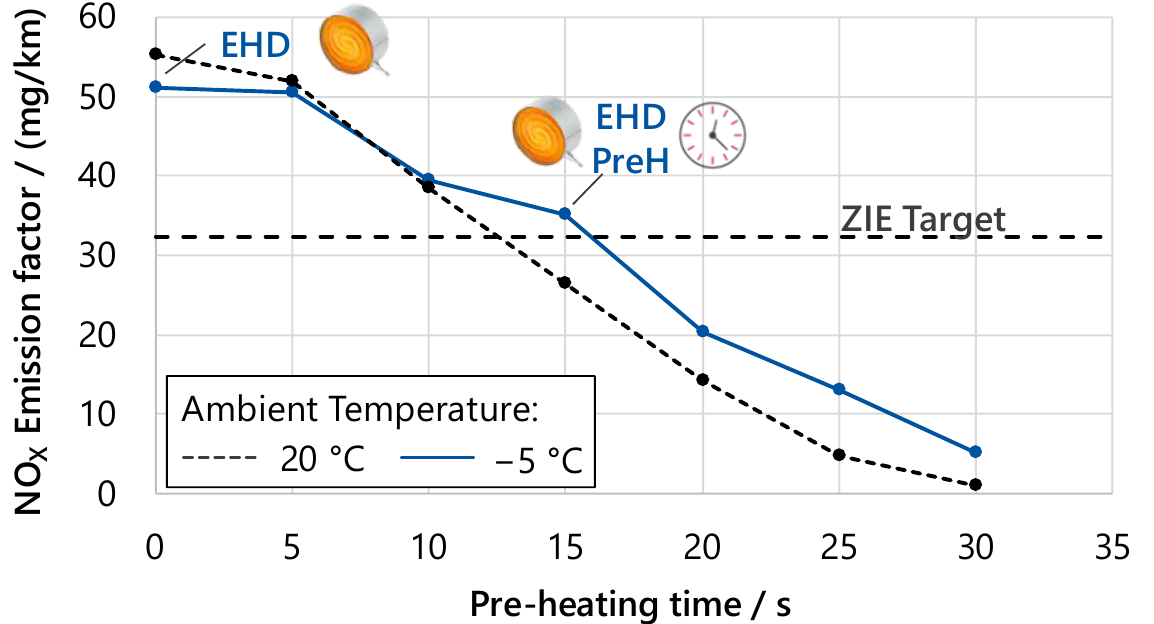
Figure 15. Variation of pre-heating time with an EHD in the Parking Area scenario for two different ambient temperatures.